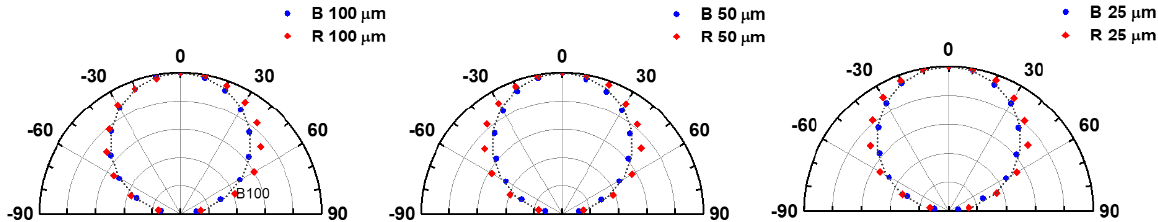
Figure 12. Measured and simulated far-field radiation of blue and red micro-LEDs with different sizes of 100 × 100, 50 × 50, and 25 × 25 μm 2 .